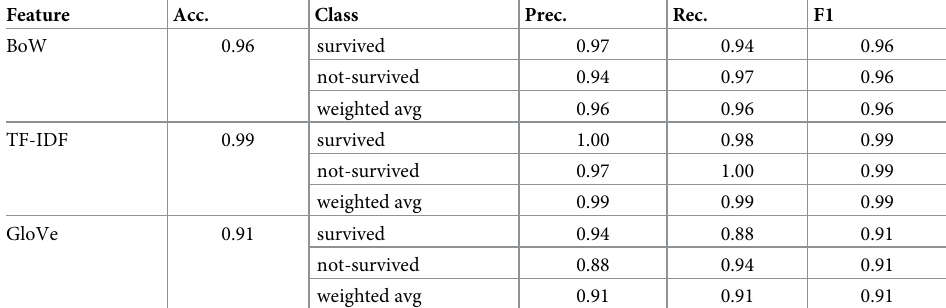
Table 15. Classification results of proposed ER-VC model for binary classification on ADASYN-balanced data. Feature